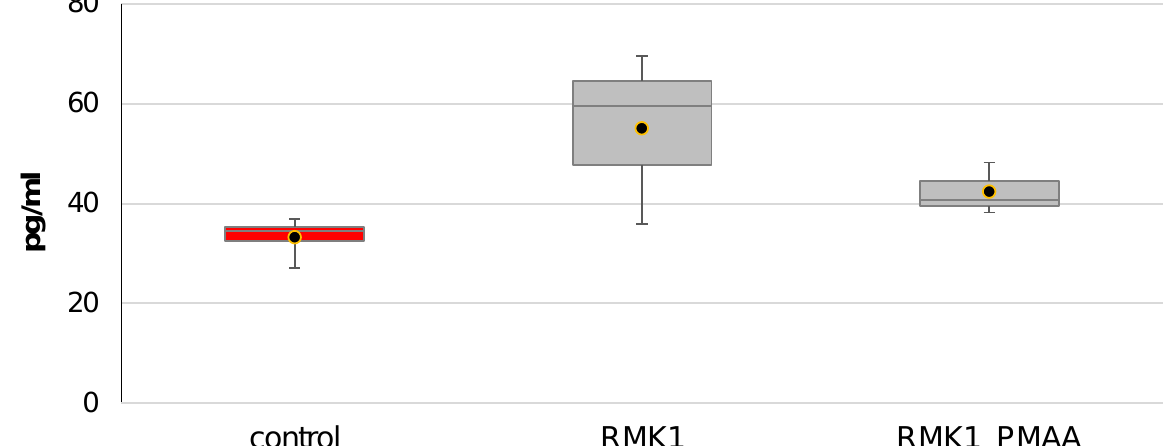
Figure 2. Changes in IL-10 concentration in response to PMAA administration.